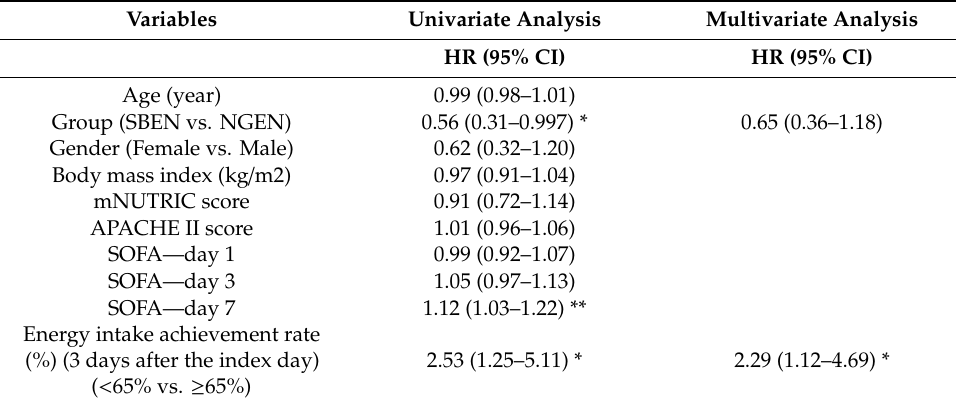
Table 4. Cox regression analysis for factors associated with hospital